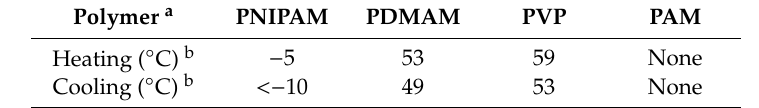
Figure 1. Polymers examined in the phase transition of 35 wt% hydrazine aqueous solutions. The numbers in the parentheses indicate the Hildebrand solubility parameters reported in [35]. Table 1. Phase transition temperatures of 35 wt% hydrazine aqueous solutions of polymers.